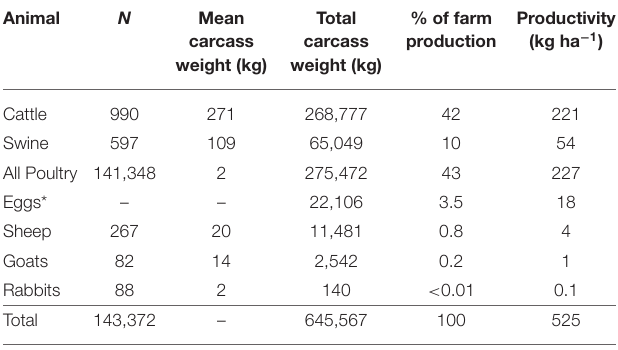
TABLE 1 | Overall market animal production and carcass output.